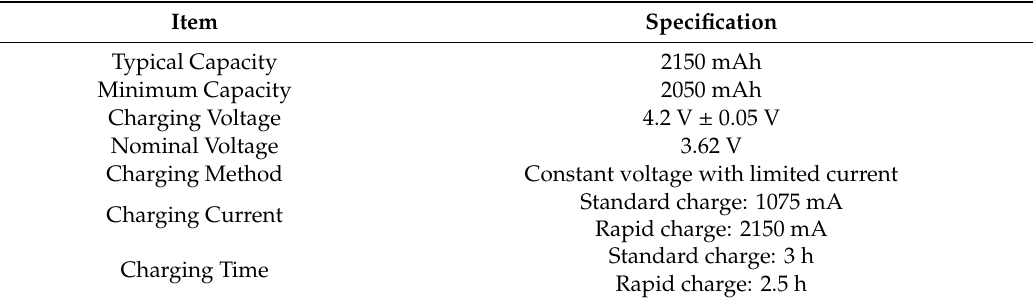
Table 1. Nominal specifications of a